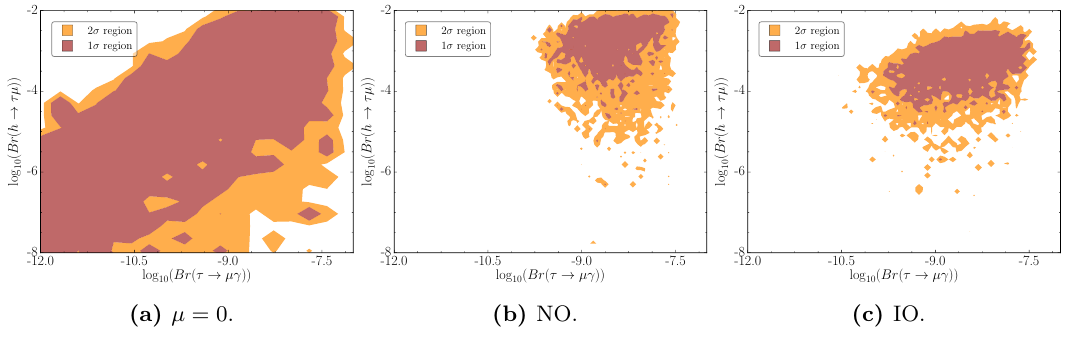
Figure 4. Allowed regions of the branching ratios Br( (cid:28) NO, and (c)